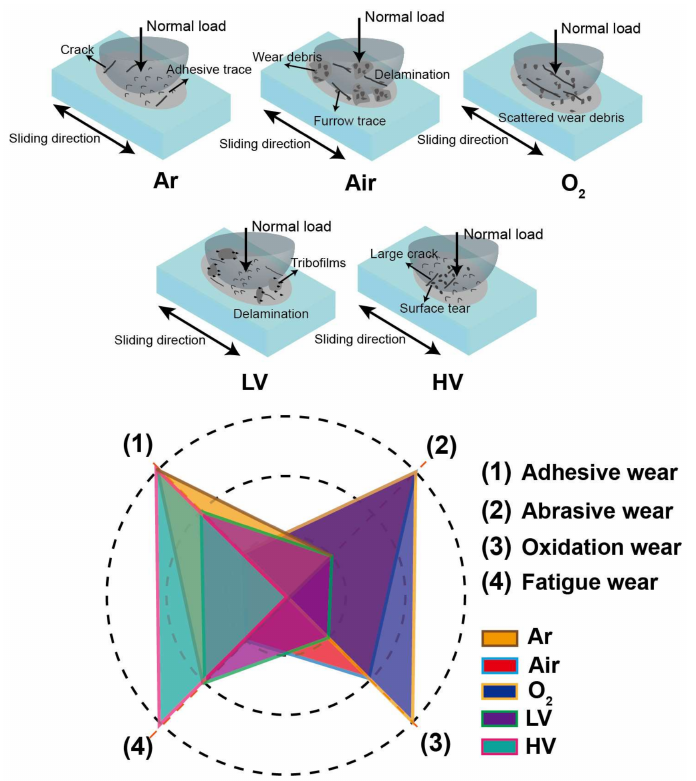
Figure 11. Schematic diagrams of the wear model and wear mechanism of uranium under different atmosphere and vacuum